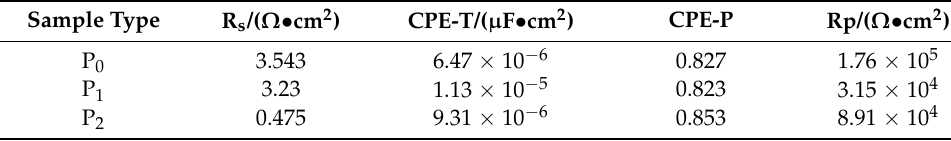
Table 3. Electrochemical impedance parameters.